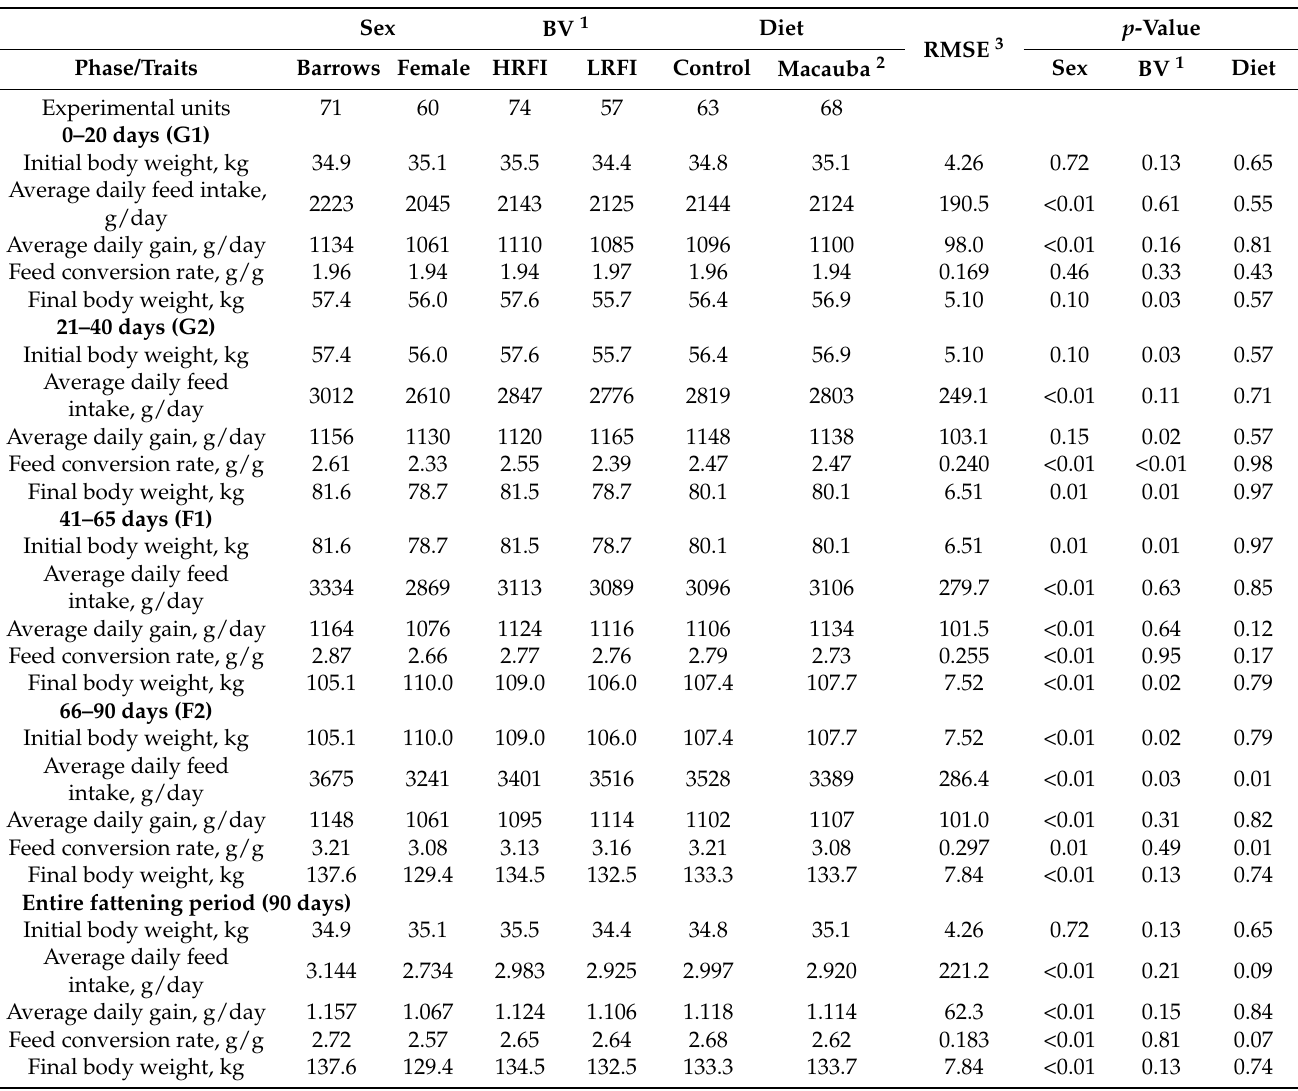
Table 3. Effect of sex, sire breeding value, and diet on performance of